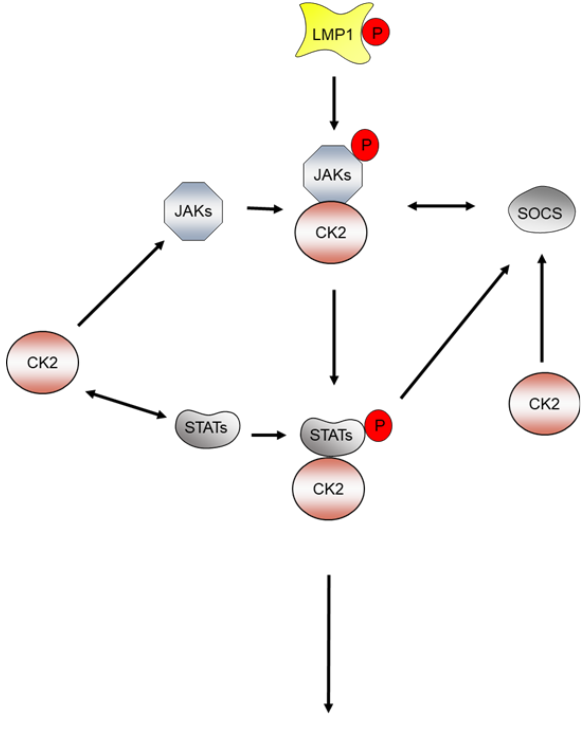
Figure 4. LMP1 and CK2 cooperate in the activation of the JASK/STAT signaling pathway. CK2 binds to JAK and STAT and phosphorylates both proteins to promote proliferation and the immune response.